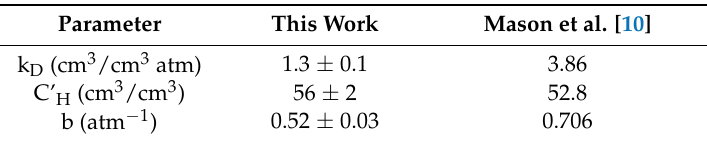
Figure 1. CO 2 sorption isotherm (cm 3 /cm 3 polymer) in original polymer of intrinsic microporosity (PIM-1) membrane as a function of pressure, the isotherm is extrapolated out to the critical pressure of CO 2 . Table 1. Dual-sorption parameters (Henry’s law constant (k D ), maximum Langmuir capacity (C’ H ) and Langmuir affinity (b) for CO 2 in PIM-1 membrane at 35 ◦